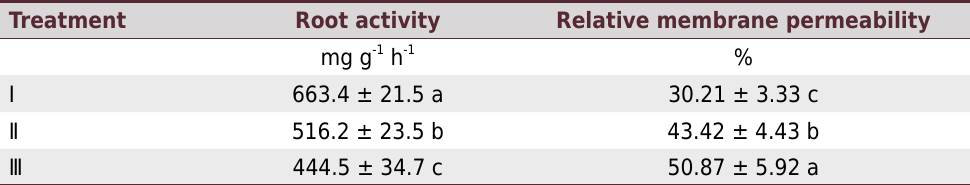
Table 2. Root activity and relative membrane permeability in different treatments